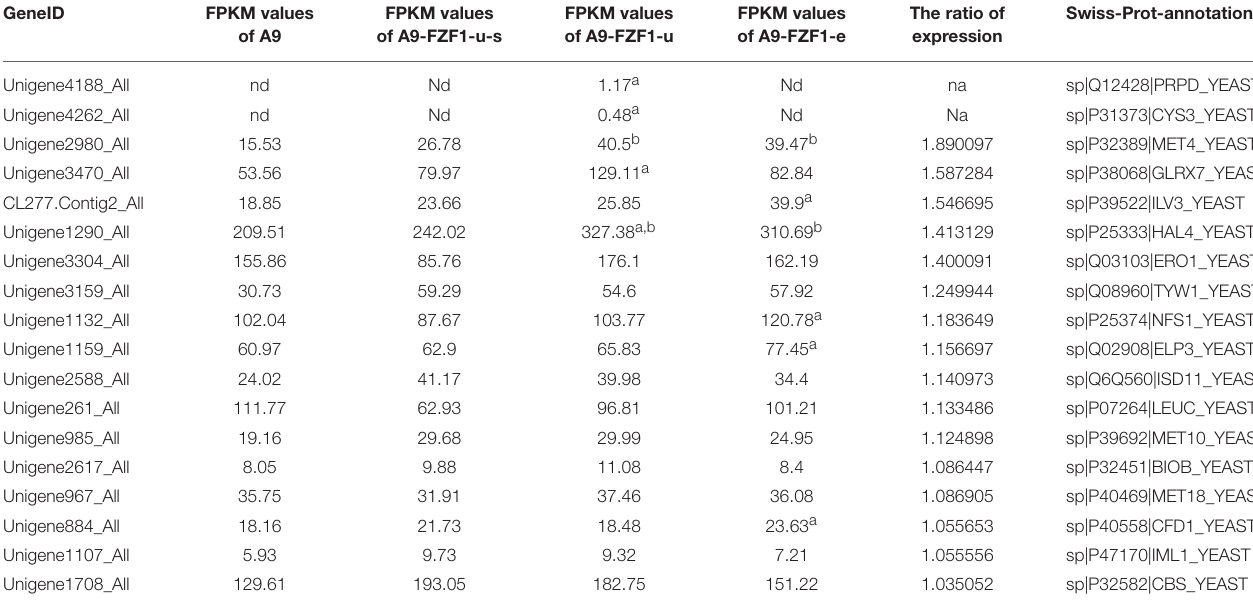
TABLE 3 | List of up-regulated genes related to sulfite or sulfur metabolism in over-expressed strains compared with A9 and the silenced strain. GeneID FPKM values